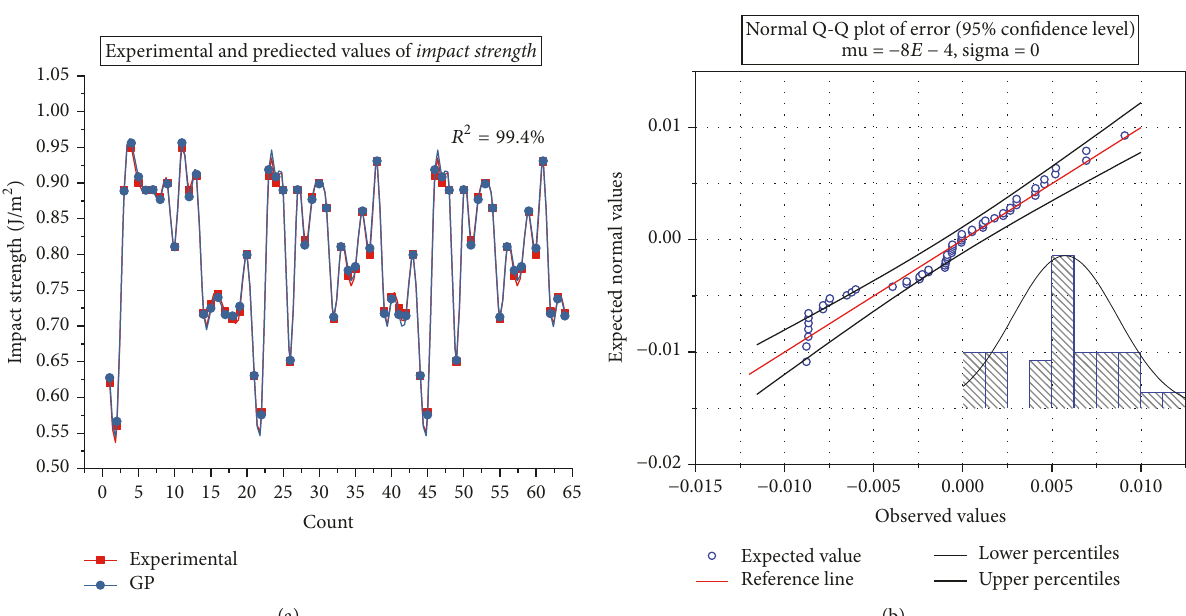
Figure 3: (a) Comparison between experimental and predicted values of impact strength and (b) normal Q-Q plot of error between experimental and GP data.